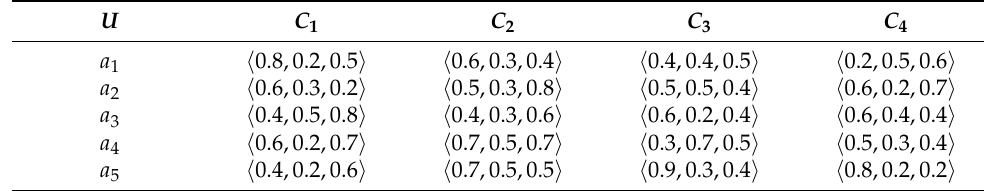
Table 5. A three-way fuzzy β -covering (cid:98) C .